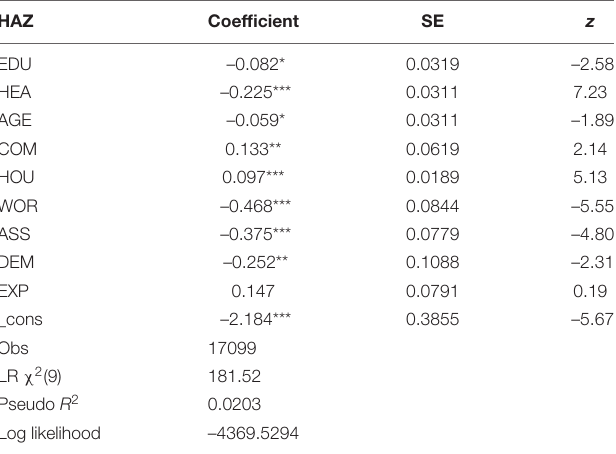
TABLE 3 | Estimation results of the Logit